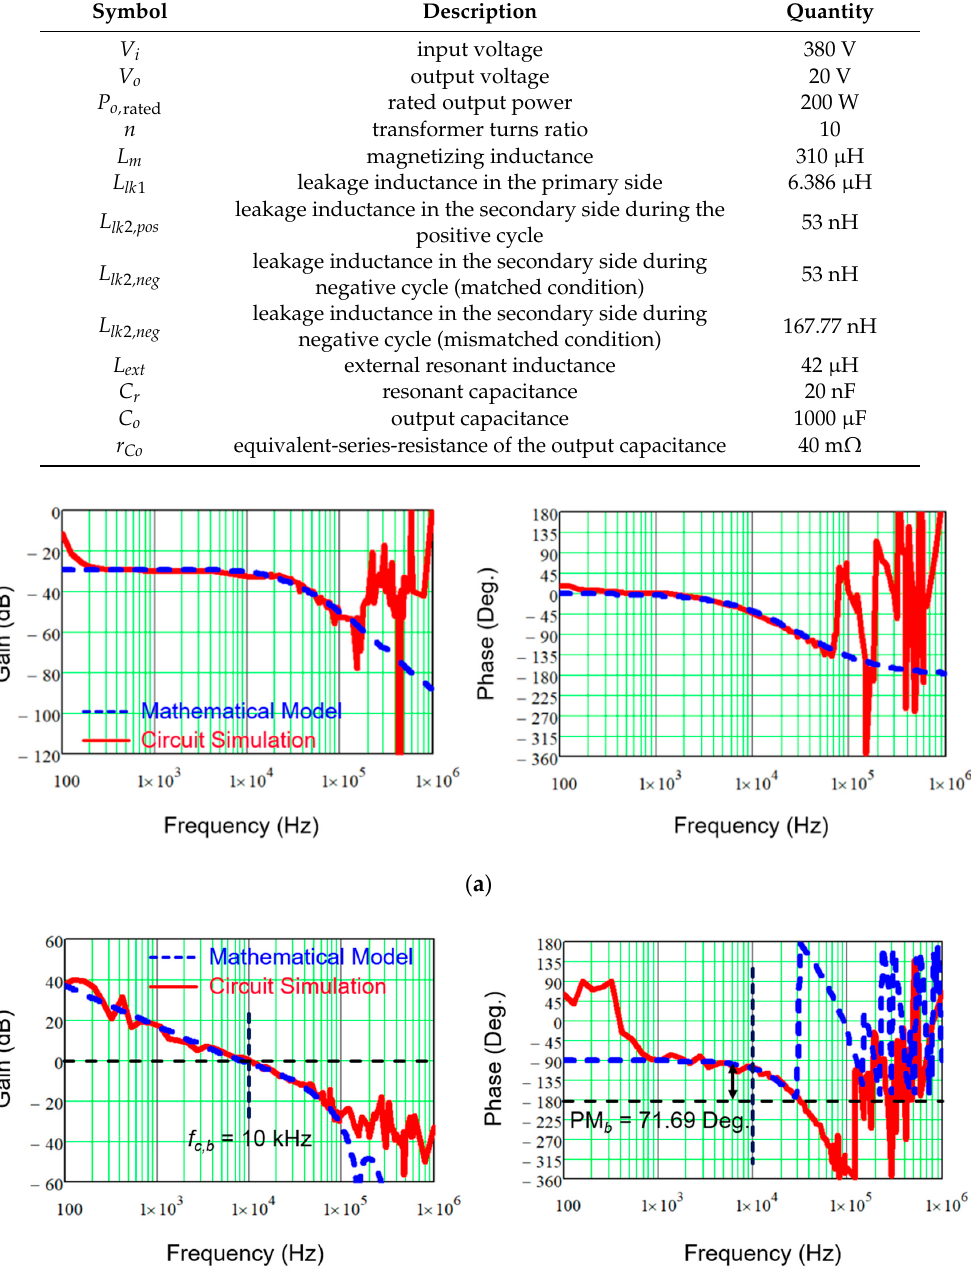
Table 1. Parameters of the LLC resonant converter.